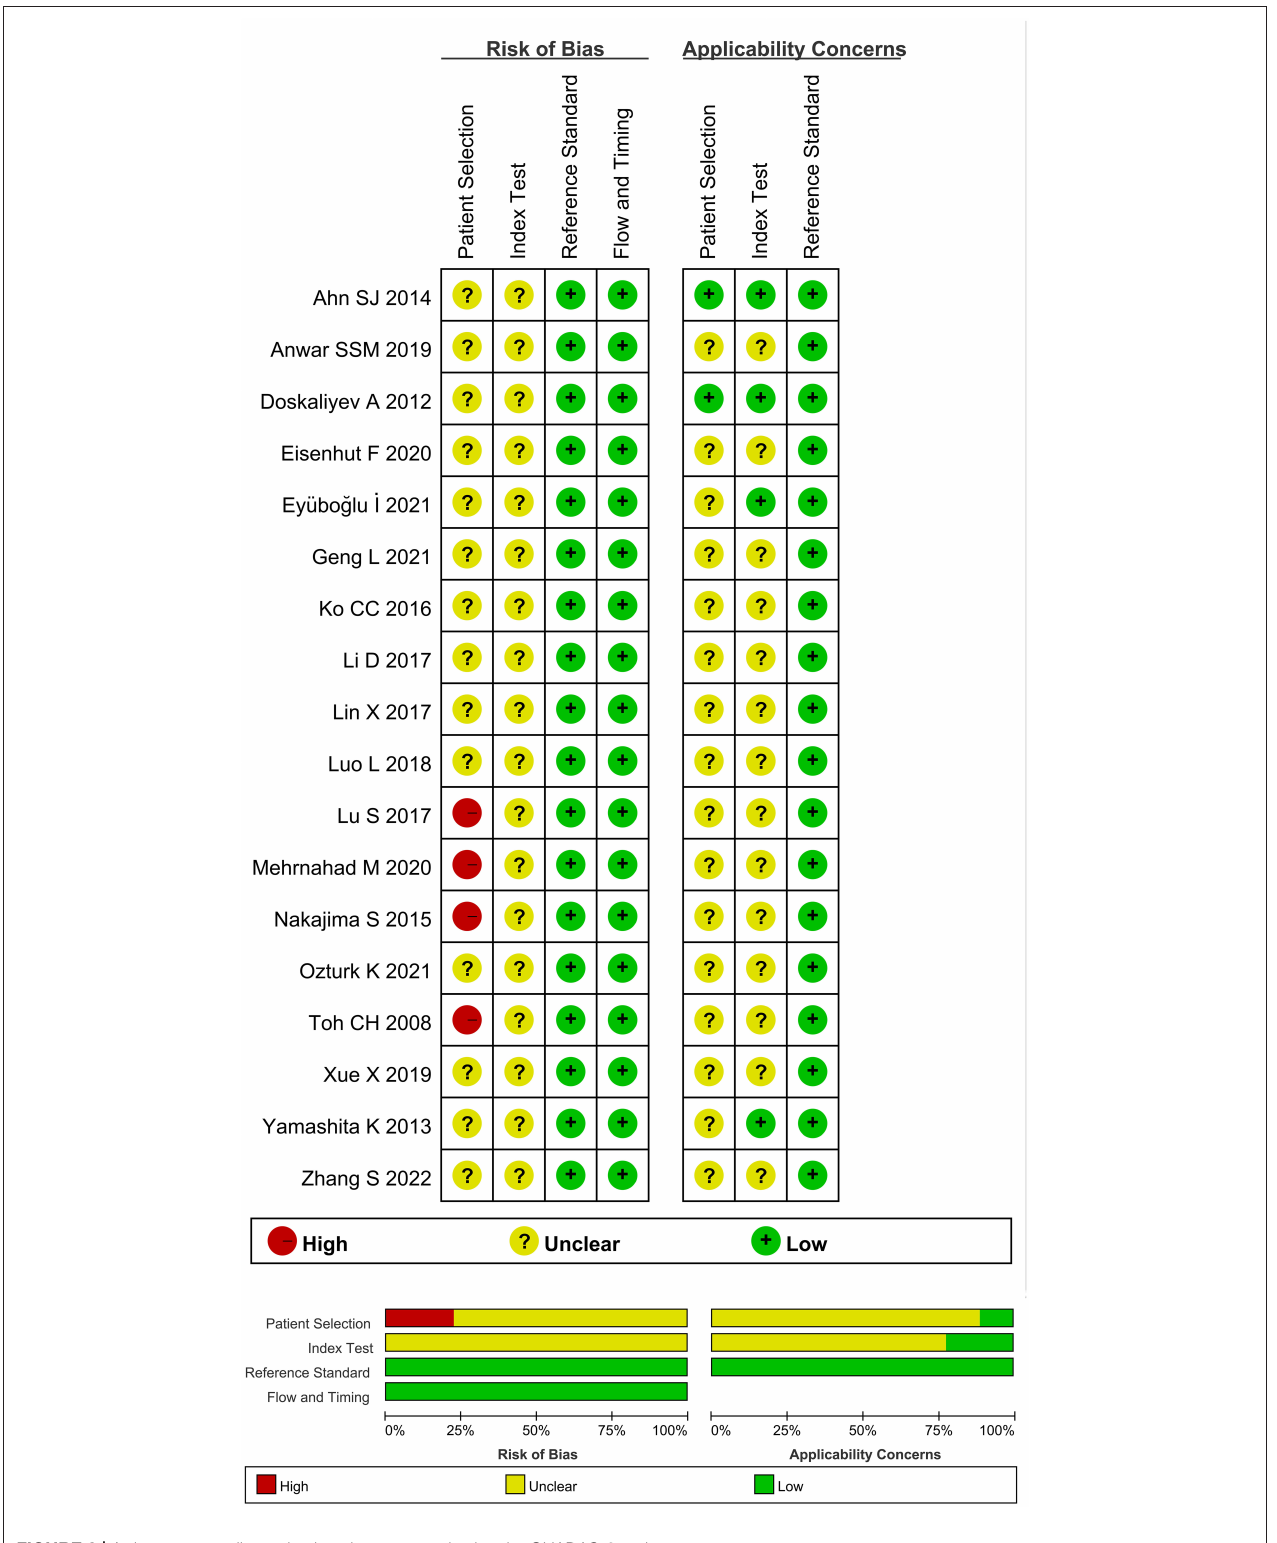
Frontiers in Neurology |